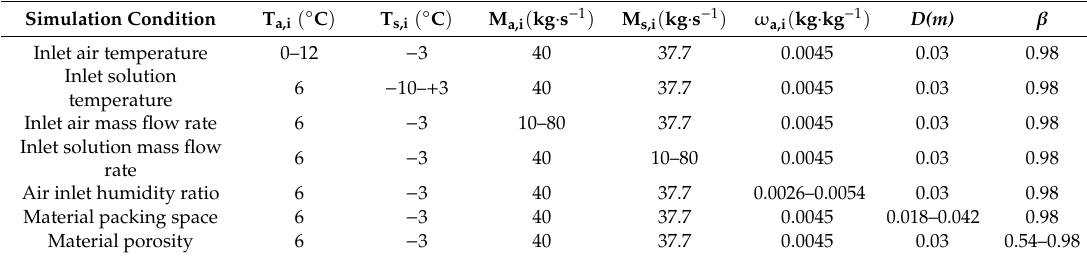
Table 4. Simulation boundary